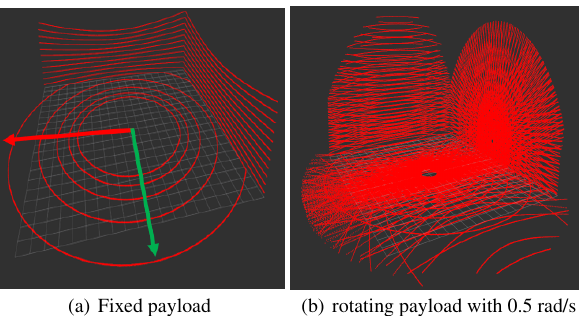
Figure 6. Comparison between fixed and rotation payload on perpendicular and parallel